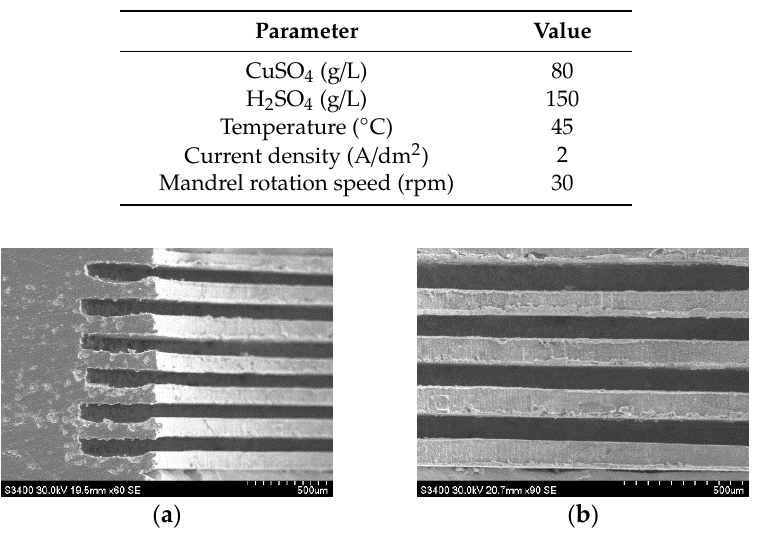
Figure 18. The SEM photographs of internal corrugated structures: ( a ) cross-section view; ( b ) enlarged view.